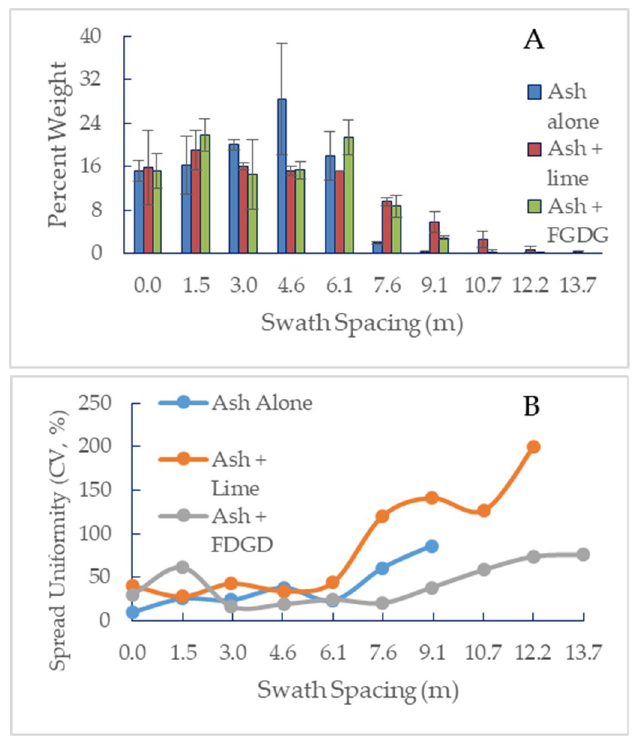
Figure 2. Spread pattern of the fertilizer applicator truck for poultry litter ash and ash mixed with calcitic lime or flue gas desulfurization gypsum (FGDG): ( A ) Average weight percent of the products at each swath spacing with respect to total weight caught in the pans; ( B ) Coefficient of variation (CV%) of spread uniformity. Swath spacing in the x -axis represents the catch pans placed 1.5 m apart along a line perpendicular to direction of travel. Error bars indicate ± one standard deviation.